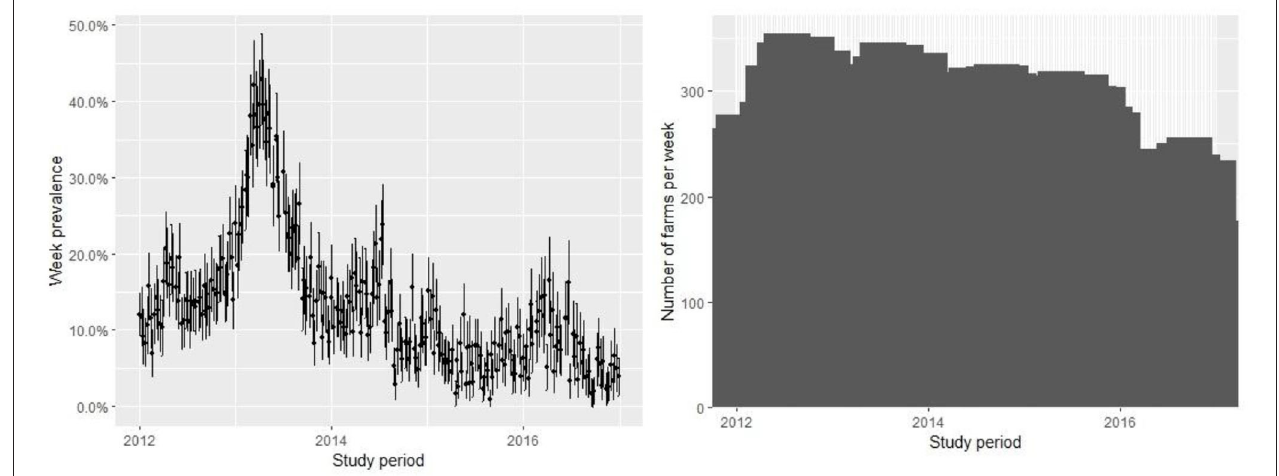
FIGURE 2 | Prevalence of farms with Caligus rogercresseyi abundance > 3 and 95% CI (left) and measure of active farms (right) during 2012–2016 in southern Chile. The pattern suggests an epidemic curve of prevalence and the number of farms varied with relative stability during the study period.